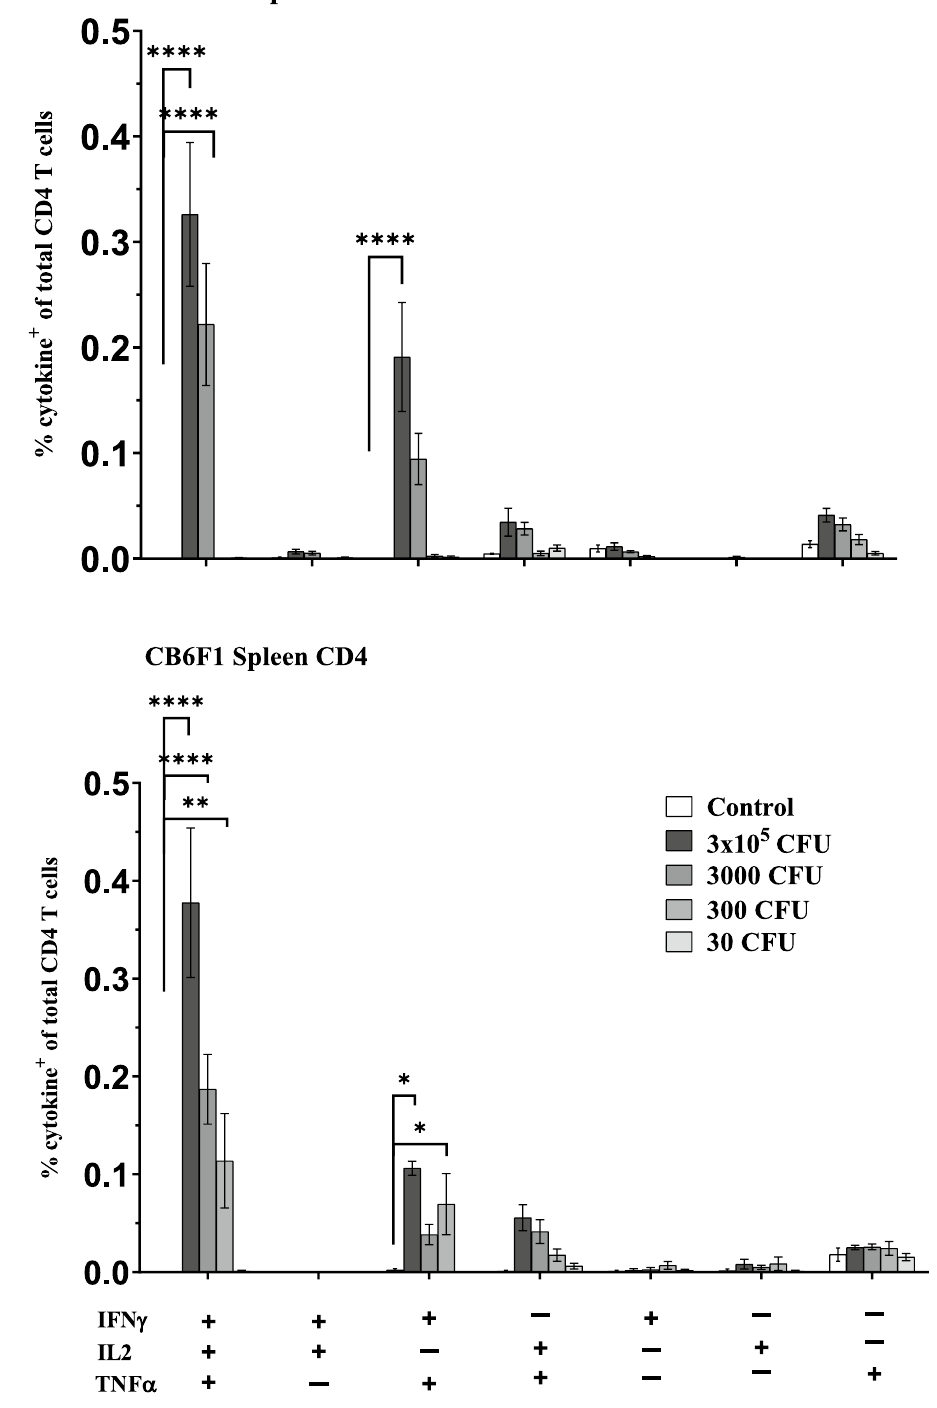
Figure 2. Vaccination induced resident multifunctional CD4 + cells in the spleen of BALB/c and CB6F1 mice. Using flow cytometry, the frequency of multifunctional CD4 + CD44 hi CD62L lo cells at 6 weeks following BCG immunization. A, splenocytes from BALB/c and CB6F1 mice (five mice/group) from the control and all BCG groups were isolated, stimulated with M7 protein cocktail and stained by ICS. Data is the representative of one independent experiment for both strains of mice. Bars represent mean (±SE) percentage frequency of cells of indicated T cell phenotype as a percentage of total CD4+ cells. Two-way ANOVA, Tukey’s multiple comparison was performed, *ρ < 0.05, **ρ < 0.005, ***ρ < 0.0005, ****ρ <